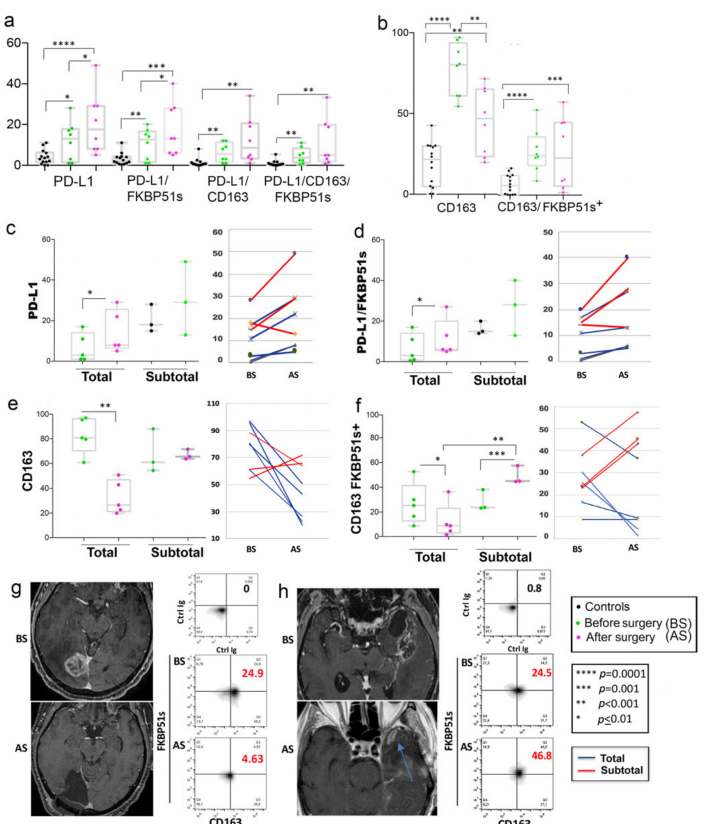
Figure 3. Effect of tumor removal on M2 immunophenotype ( a ) Boxplots of pre-operative and post-operative counts of whole PD-L1+ monocytes and their subgroups. ( b ) Boxplots of pre-operative and post-operative counts of whole CD163+ monocytes or CD163/FKBP51s+ monocytes. ( c – f ) Boxplots of pre-operative and post-operative counts are shown according to total or subtotal tumor removal: whole PD-L1+ monocytes ( c ), PD-L1/FKBP51s+ monocytes ( d ), whole 163+ monocytes ( e ), CD163/FKBP51s monocytes ( f ). In any panel, the line graph on the right shows the post-operative changes for each patient. Boxplots were generated using Prism GraphPad 7.0a Macintosh; line graphs were generated using Microsoft Excel.app 16.43. ( g ) T1 W post-gadolinium images of a patient with total resection and ( f ) a case of subtotal resection ( h ). Blue arrow indicates the residual part of the tumor. Before-surgery images (BS) and after-surgery images (AS) are shown along with flow cytometry histograms of CD163/FKBP51s+ monocytes (highlighted in